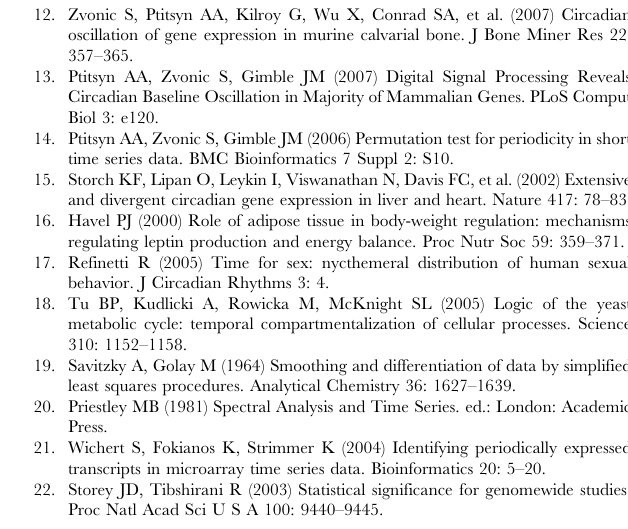
Figure S3 Expression profiles of the tree S.cerevisae probesets with p , 0.1 by both Pt-test and Fisher’s g-test. All three are never called present at any single time point. AFFX-BioDn-5_st represents a control sequence of bacterial origin which should not be present. Oscillating pattern of this probeset may be caused by a small contamination of the yeast culture with E.coli or cross- hybridization from the nearest yeast homologues of dethiobiotin synthetase. Two other probesets (6617_at and 7889_at) are annotated as ‘‘dubious ORF’’ and ‘‘nonessential protein’’. Found at: doi:10.1371/journal.pone.0001842.s003 (0.09 MB DOC) Code S1 This is an abbreviated C ++ program that illustrates the concept of detection call based on the principle of Stochastic Resonance. Found at: doi:10.1371/journal.pone.0001842.s004 (0.41 MB